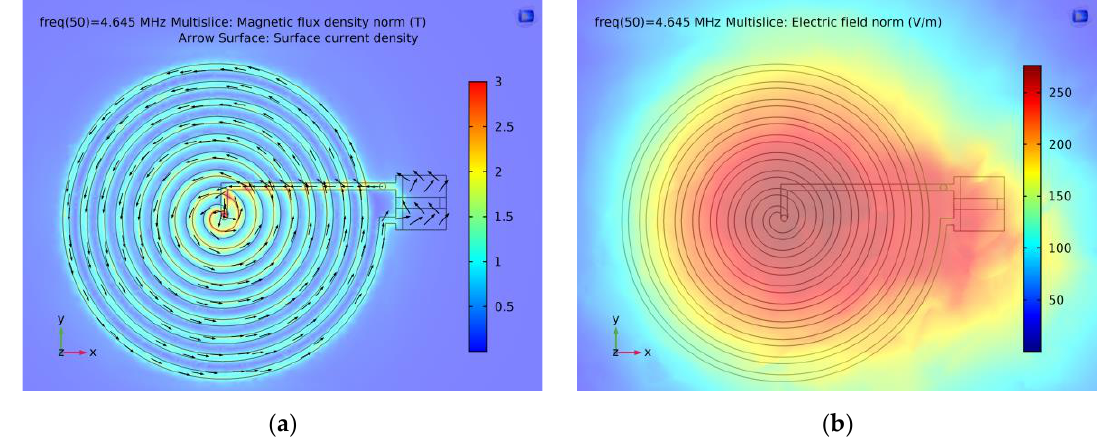
Figure 4. Visualization of the results of simulation of the EM field in the vicinity of the conductive elements of the NQR-detector-antenna model shaped as Archimedean spiral at a frequency of 4.645 MHz: ( a ) magnetic-field induction, ( b ) electric-field strength.